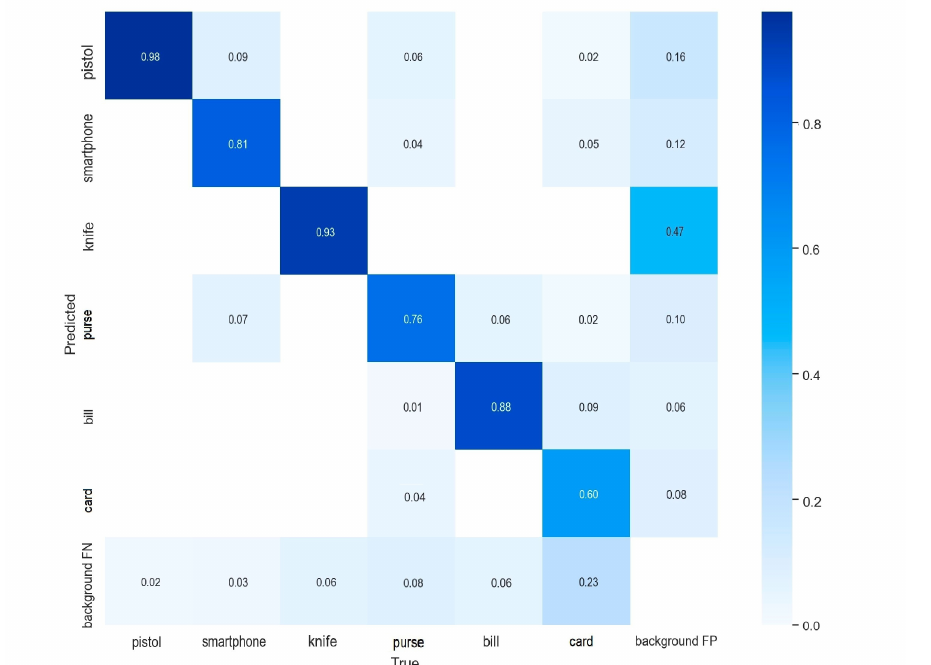
Figure 5. Confusion matrix showing the results distribution among all class when employing YOLOv5n